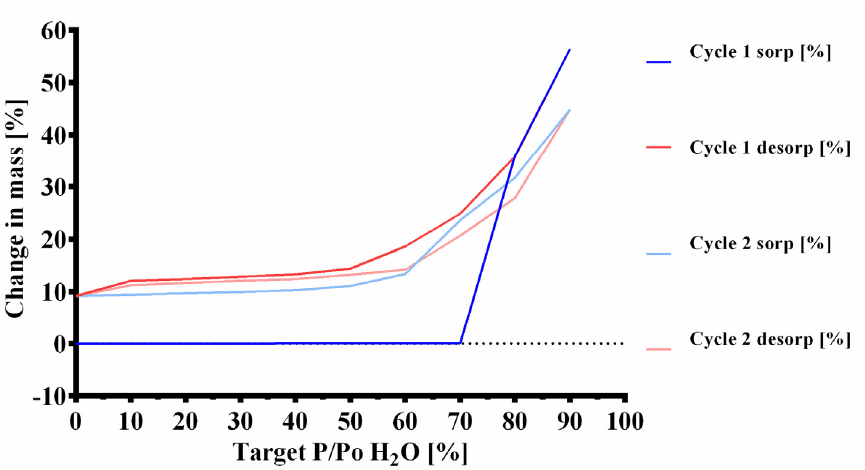
Figure 7. Dynamic vapor sorption isotherm analysis. Two sorption and desorption cycles (sorp = sorption; desorp = desorption) of an effervescent granule formulation containing mannitol as a filler from the same DVS measurement as in Figure 5 are displayed. Table 4. Hydrogen generation and weight gain of the bulk stability samples expressed as mean and (SD). Storage